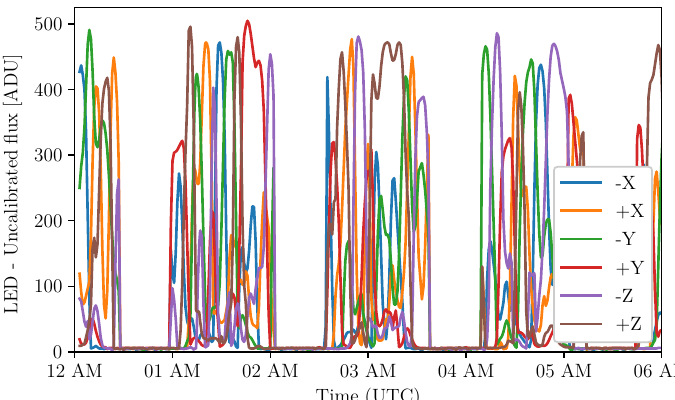
Figure 9. Solar cells temperature for all UVSQ-SAT faces. Measurements start from 7 February 2021 at 12:00 AM (UTC). The orbital period is about 95.18mn. UVSQ-SAT spins during the orbit.